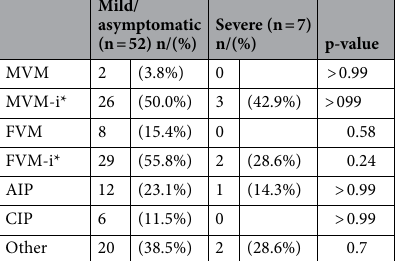
Mild/ asymptomatic